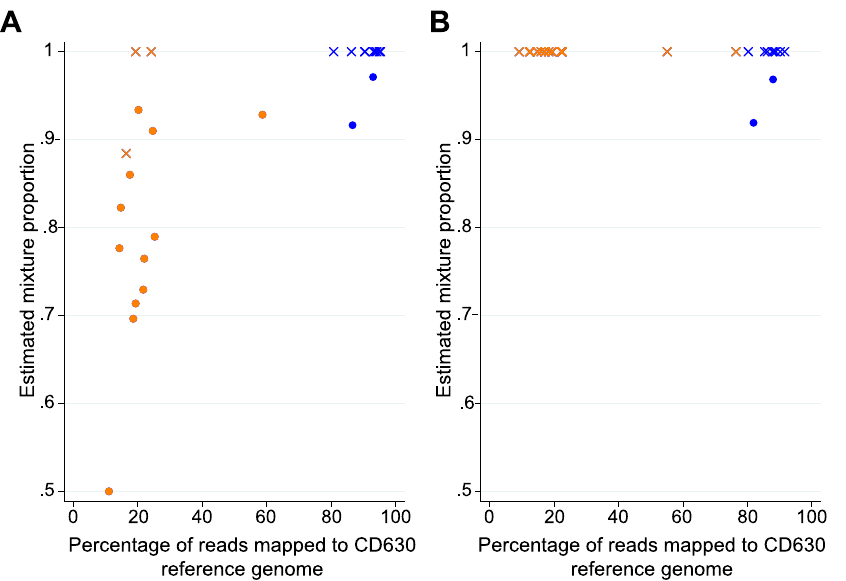
Figure 3. Reads mapped and estimated mixture proportion for possible mixed-ST clinical infections, across two alignment programs. Points in orange show evidence of contamination with other bacteria (i.e. , 80% of reads mapped to reference genome), other points are shown in blue. Mixed infections detected using a 2 2 log likelihood ratio statistic threshold of $ 19.4 (as defined in the calibration samples) are shown as filled circles, other points are shown as crosses. Panel A shows the data obtained from alignments generated using Stampy. Stampy is designed to perform well with relatively high sequence variation relative to the reference, in particular insertions or deletions. In the more contaminated samples we observed markedly divergent reads from other species mapped to the highly conserved MLST loci resulting in falsely identifying mixed infections. Panel B show the data obtained from alignments generated with Burrows Wheeler Aligner. Two mixed infections were detected.